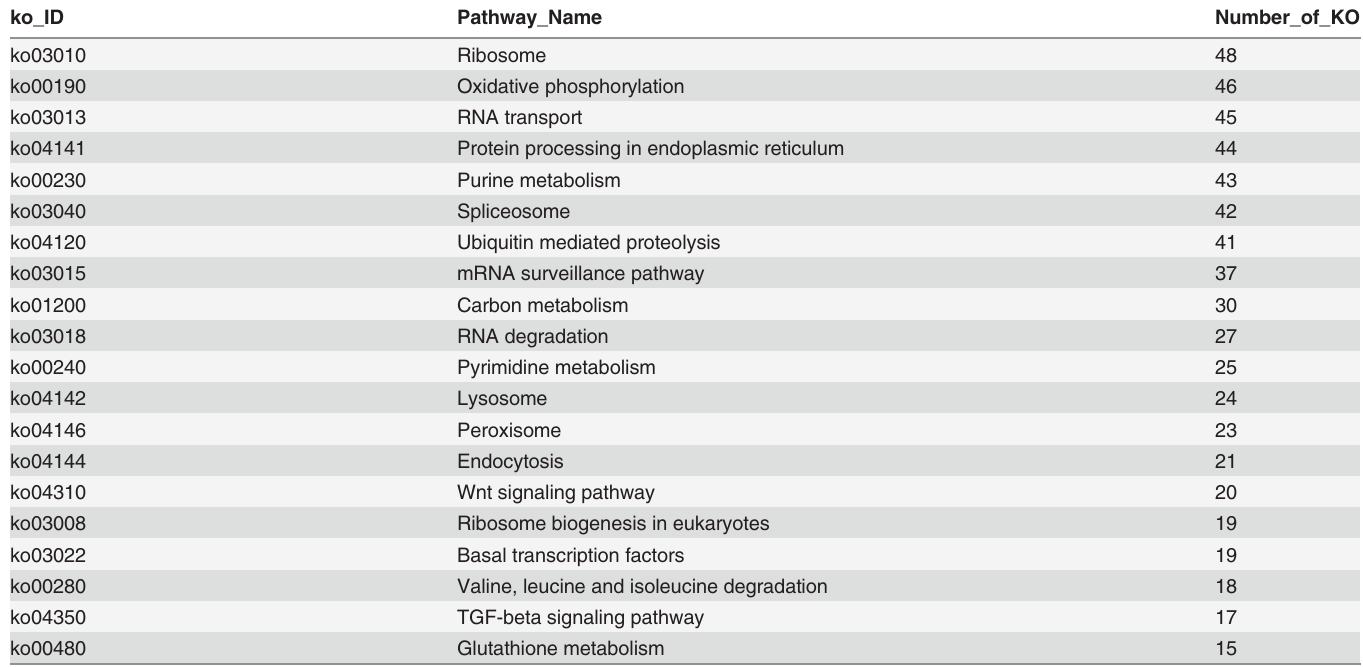
Table 1. The top KEGG pathways of potential target genes for the validated miRNAs.